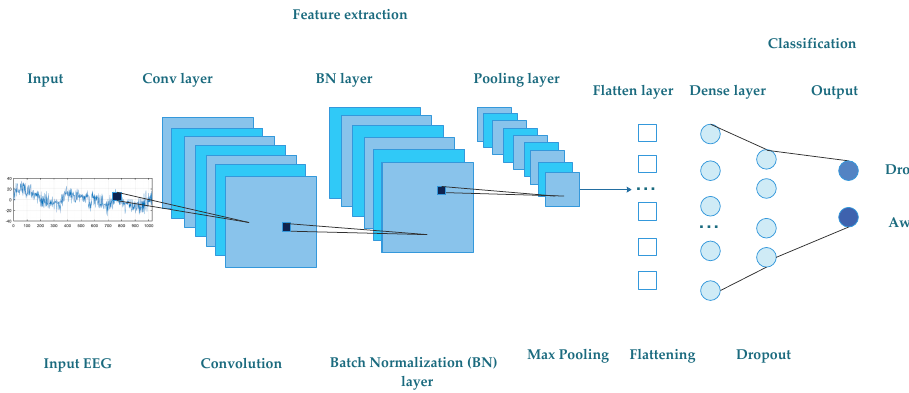
Figure 5. Diagram of the proposed convolutional neural network (CNN) model.